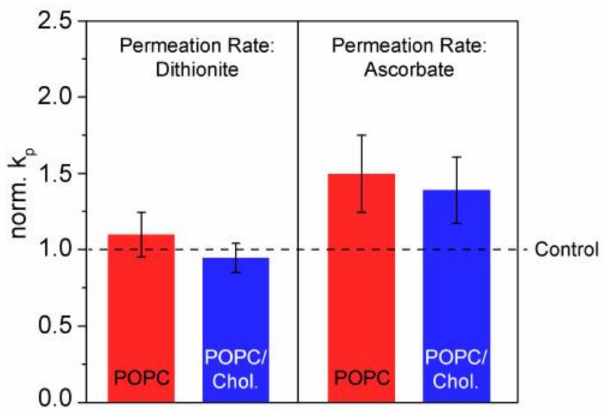
Figure 3. Normalized rate constants (k P ) for dithionite (left) and ascorbate (right) reflecting the permeation of the respective anion across the membrane in POPC and POPC / Chol (80 / 20, mol / mol) LUVs. k P values determined in the presence of ibuprofen (molar ratio lipid / drug = 5:1) were normalized to those determined in the absence of the drugs. For the dithionite assay, vesicles contained 1 mM lipid and 0.5 mol% NBD-PC. For the ascorbate assay, the lipid concentration was 2.5 mM and 2 mol% SL-PC. The data represent the mean ± SE of ≥ 6 (dithionite) and 8 (ascorbate) independent